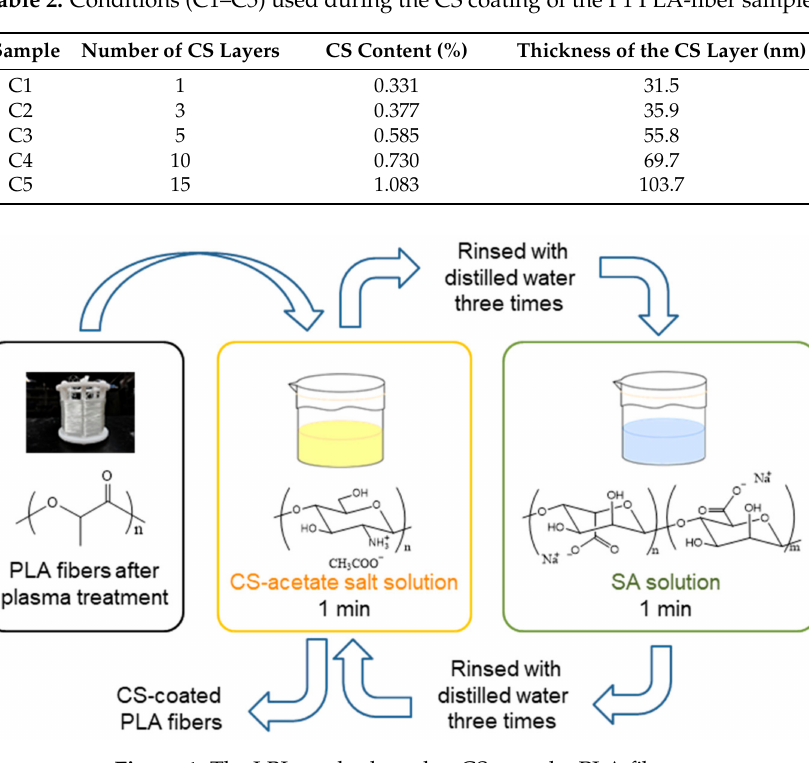
Figure 1. The LBL method used to CS-coat the PLA